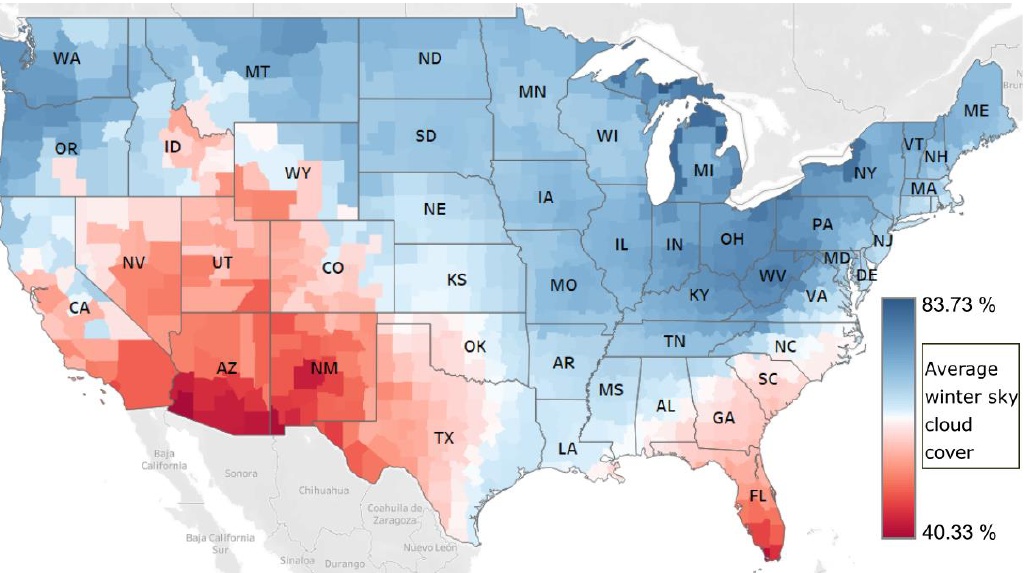
Figure 2. Average cloud cover during the winter in percent for every county in the continental United States.